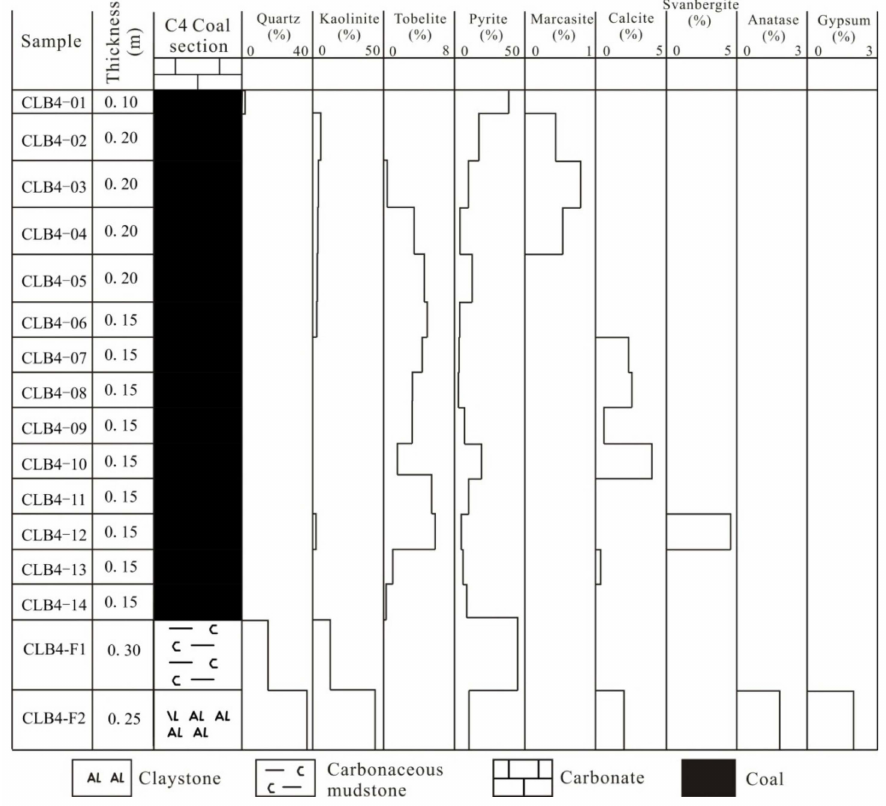
Figure 3. Vertical distribution of the minerals identified in the C4 Coal (on whole-coal